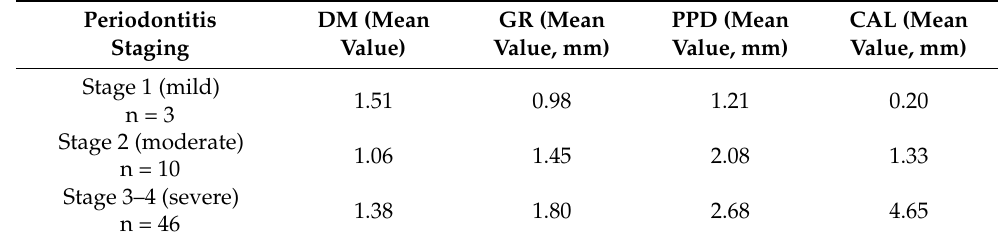
Table 2. Periodontal parameters in the study group in correspondence to periodontitis staging.